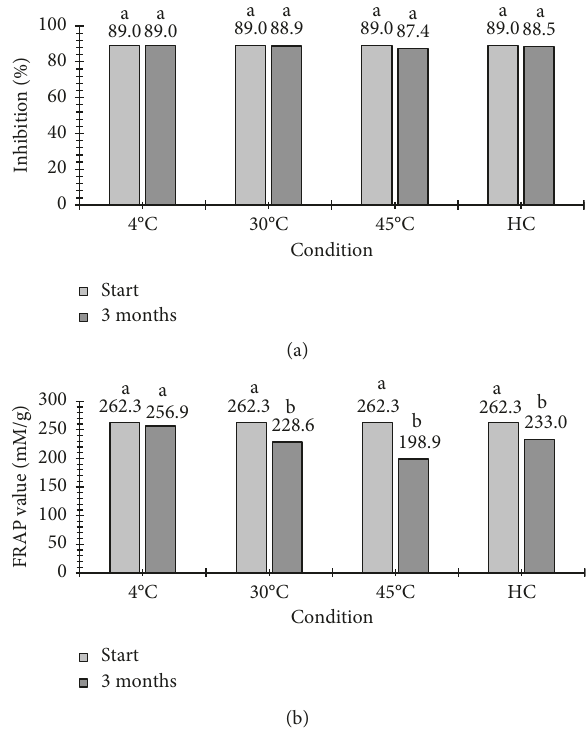
Figure 6: Antioxidant activities of CP-loaded NLCs by (a) DPPH and (b) FRAP assays before and after stability test at 4 ° C, 30 ° C, and 45 ° C and heating-cooling (HC) cycles. Different letters within the same condition mean significant difference ( p < 0 . 05).